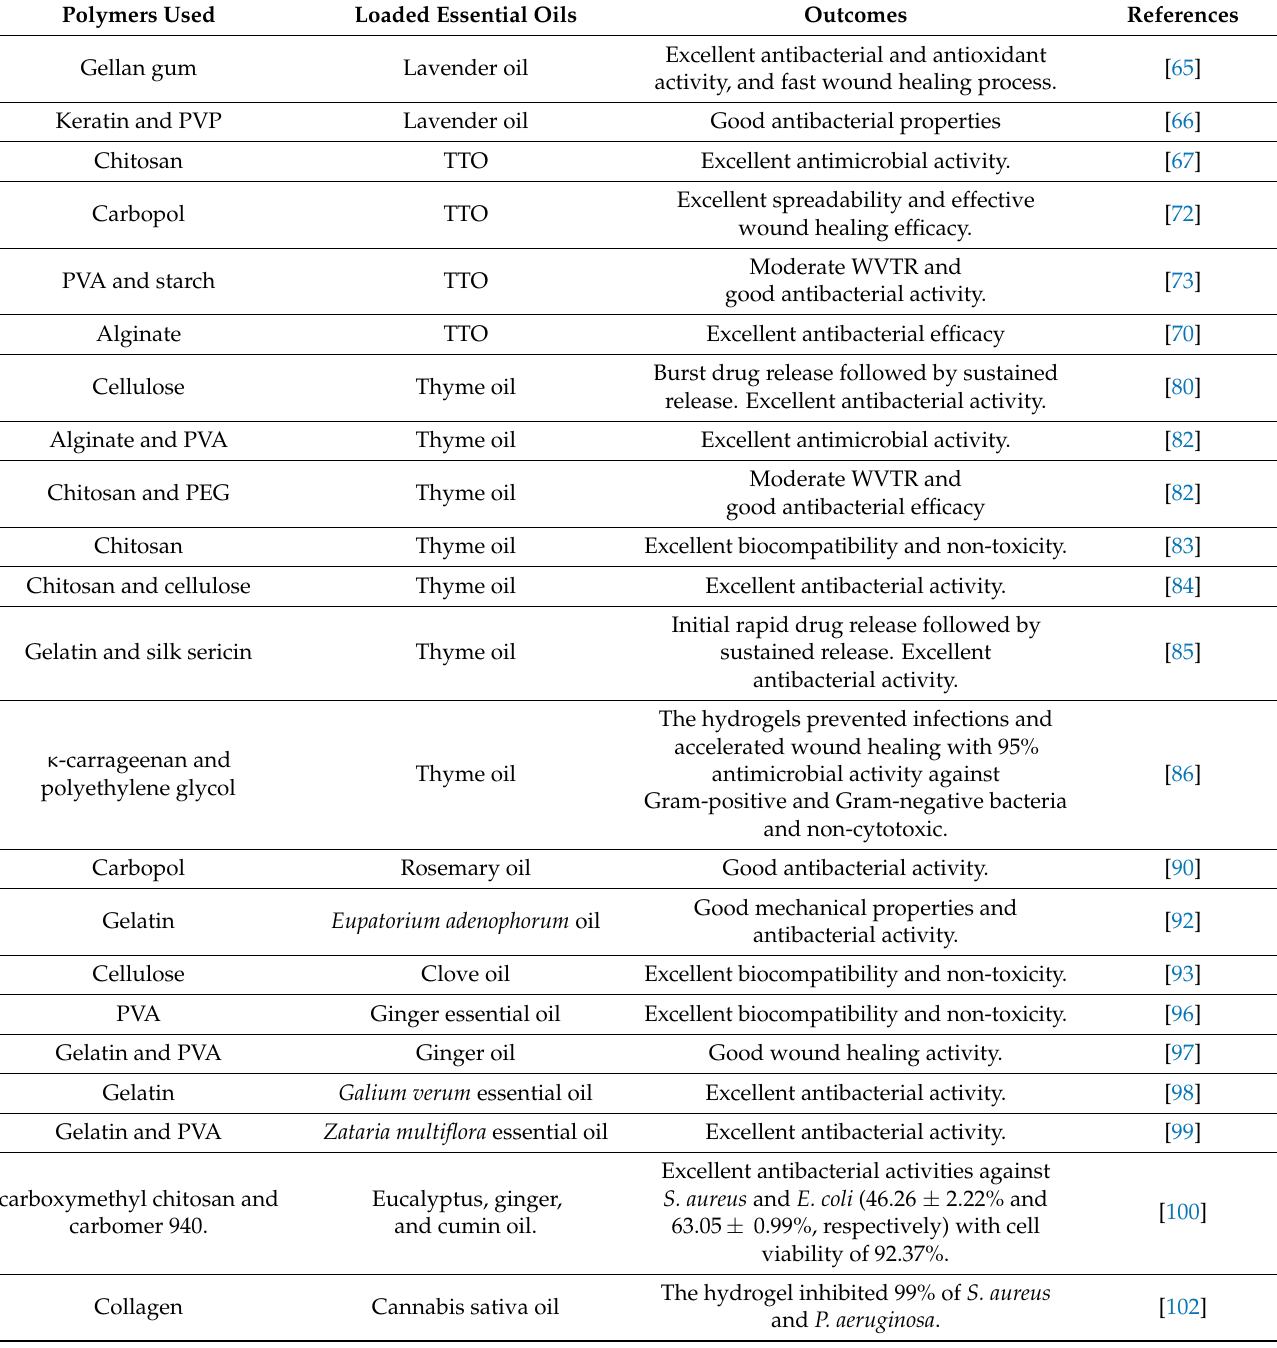
Table 1. A summary of the therapeutic efficacy of polymer-based hydrogels enriched with essential